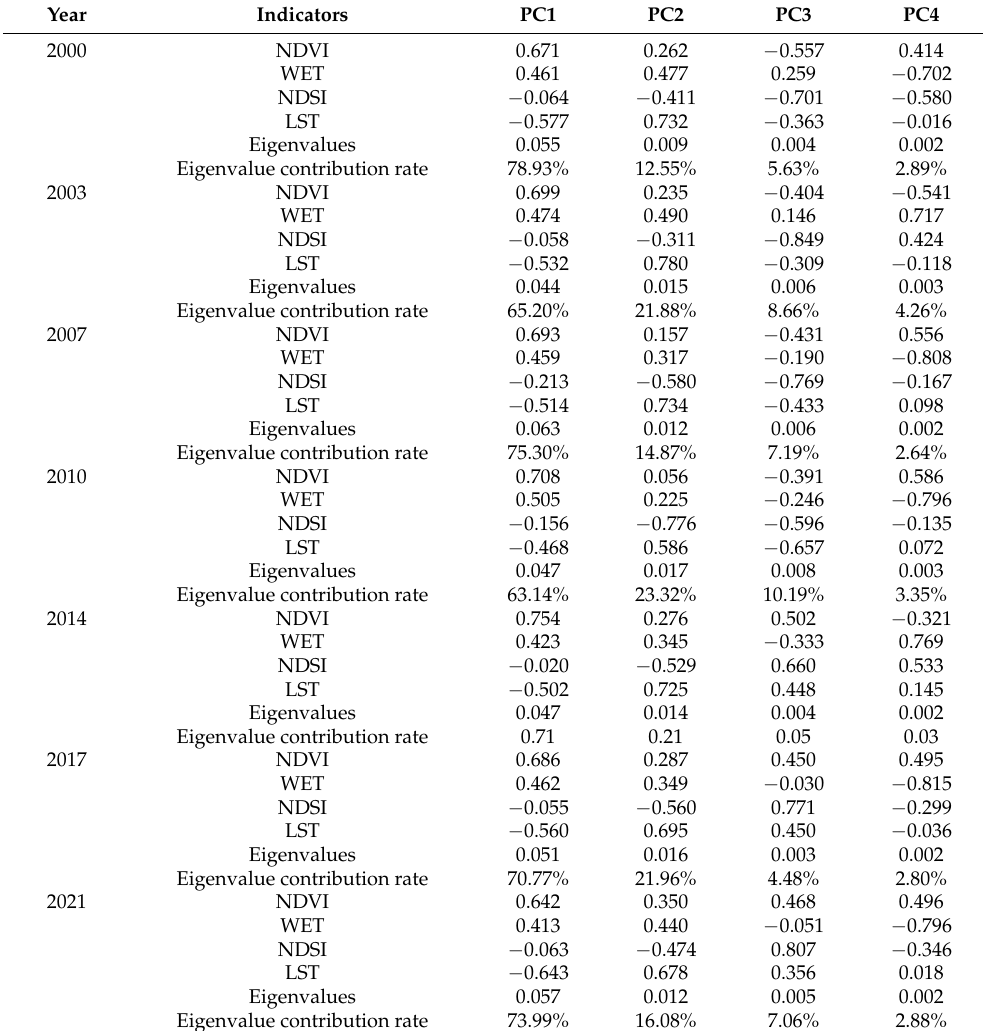
Table 3. Results of principal component analysis for each indicator in the Weihe River Basin for the RSEI during